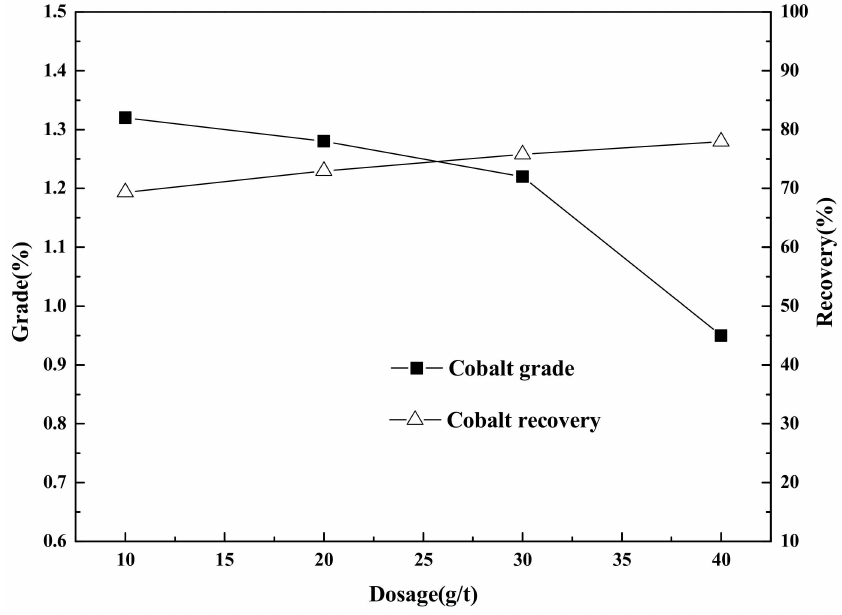
Figure 3. E ff ect of butyl xanthate dosage on cobalt grade and recovery in